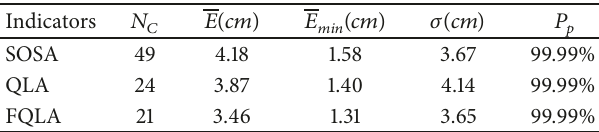
Table 2: Performance indices of three algorithms with 100 initial